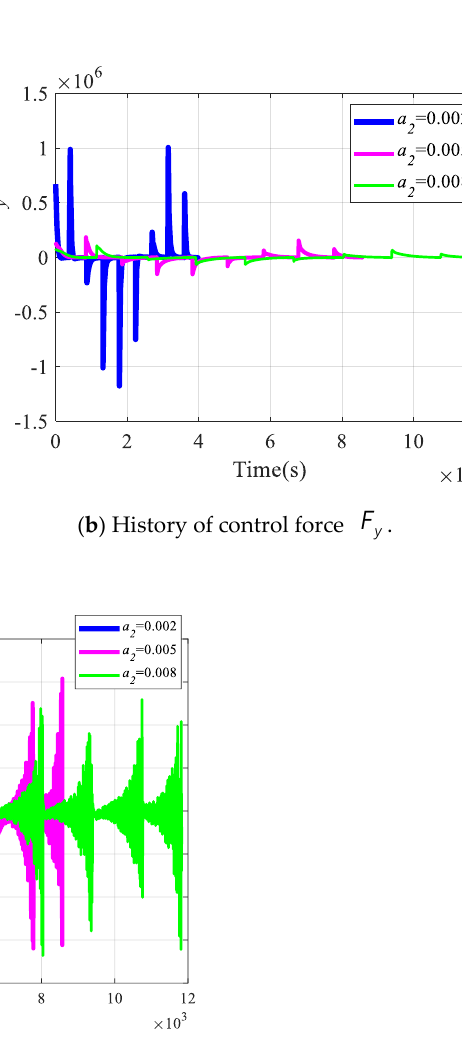
Figure 15. Tracking errors of controlled AUSV with respect to different control gains